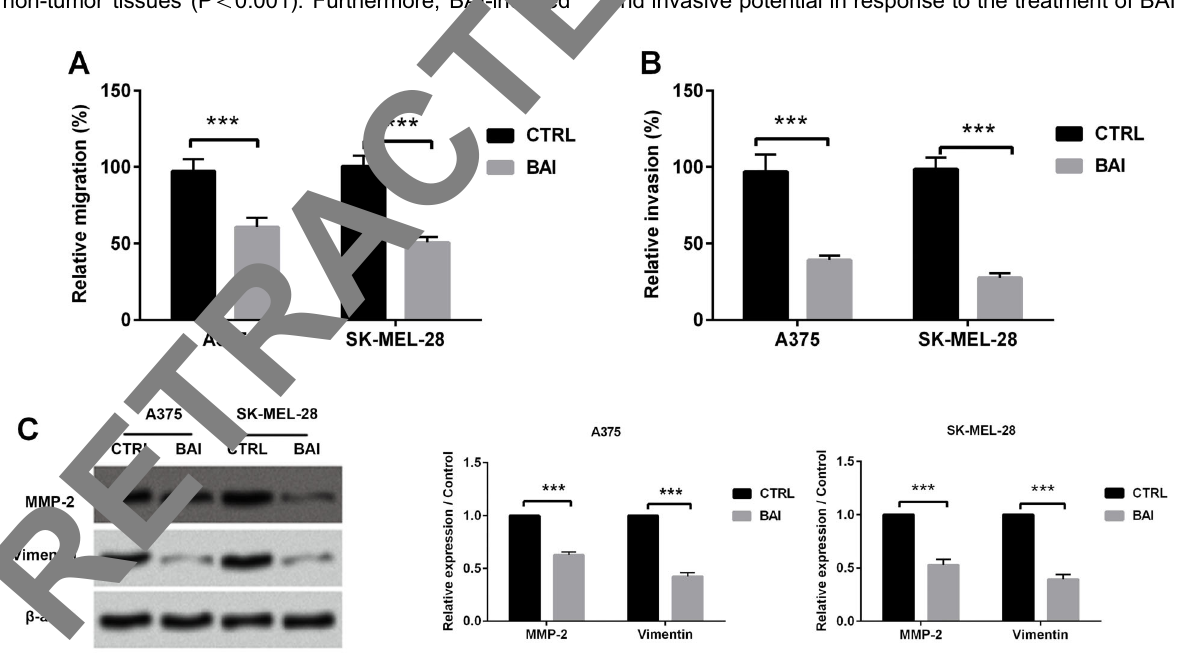
Figure 2. Baicalein (BAI) inhibited the cell migratory capacity and invasive potential of melanoma cells. A , Migration of A375 and SK-MEL-28 cells, treated or not with BAI, was examined by transwell assay. B , Invasion of A375 and SK-MEL-28 cells was detected by transwell assay with Matrigel matrix. C , Protein expression of MMP-2 and vimentin was tested by western blot assay. The relative expression of protein was normalized by b -actin. Data are reported as mean ± SD. ***P o 0.001 ( t -test). CTRL: